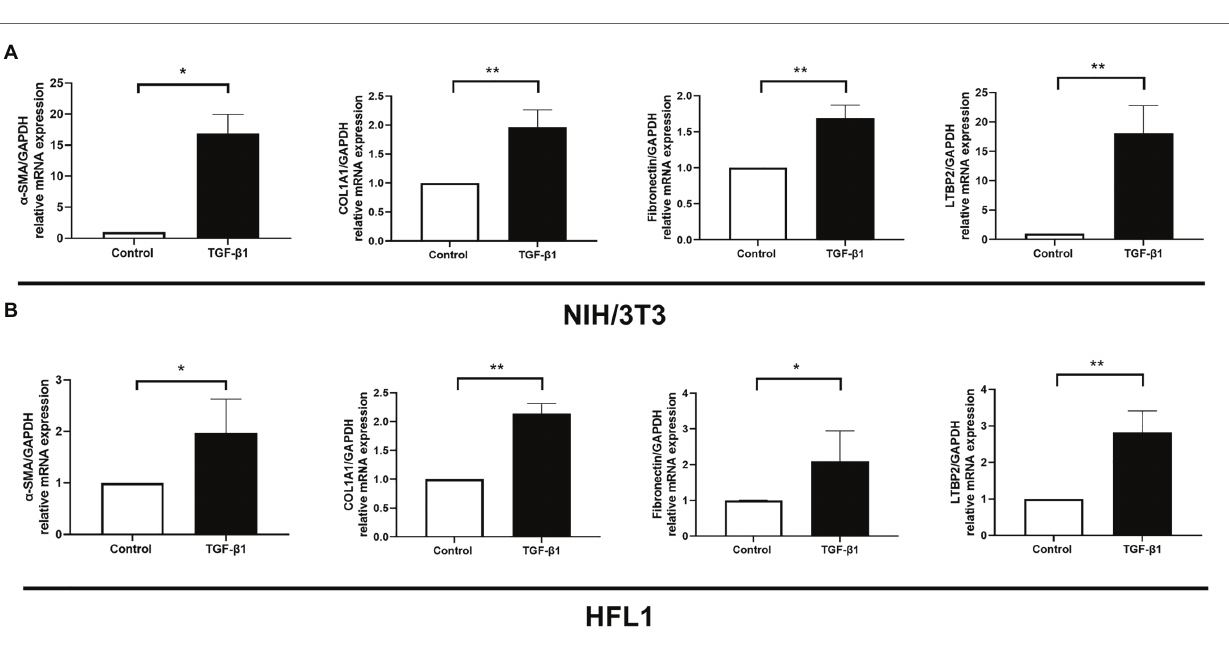
FIGURE 4 | LTBP2 was highly expressed in TGF- β 1-induced myofibroblasts. The mRNA expressions of a-SMA, COL1A1, fibronectin, and LTBP2 in mouse embryonic fibroblasts (NIH/3 T3; A ) and human fetal lung fibroblasts (HFL1; B ) were detected by real-time PCR after 5 ng/ml TGF- β 1 stimulation for 12 h. Data presented as mean ± SD, n = 3–4. * p < 0.05; ** p <